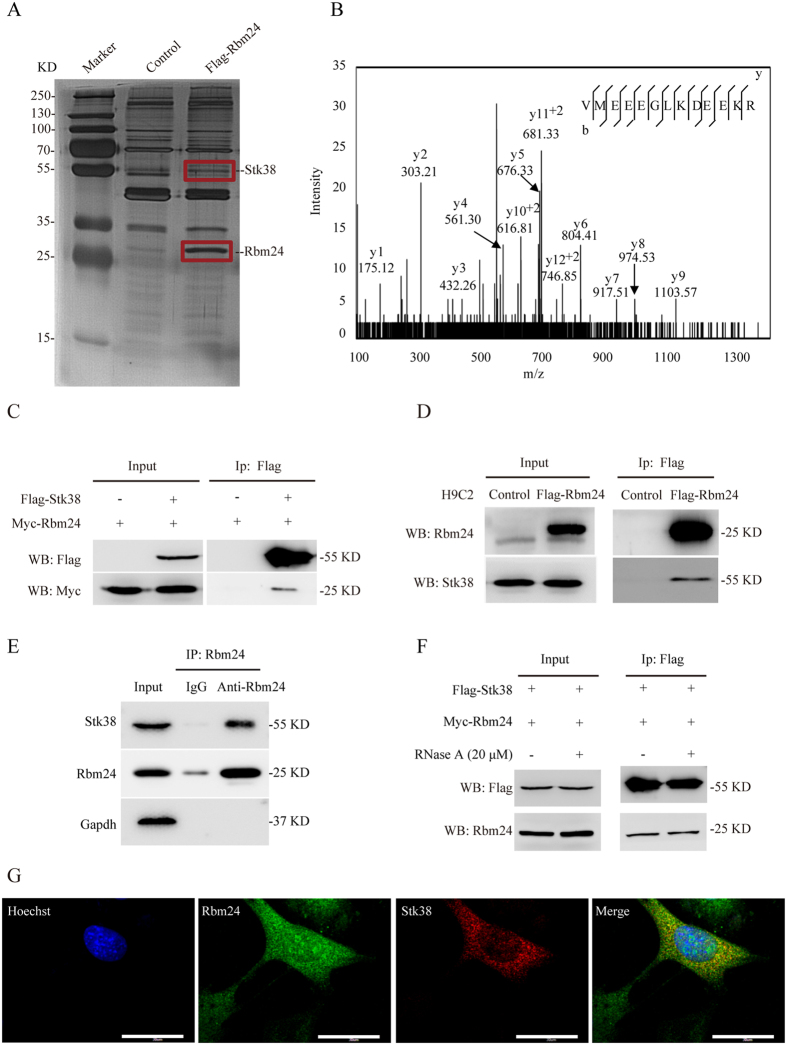
Stk38 directly interacts with Rbm24.(A) Pulldown assays with anti-Flag antibody-conjugated agarose beads were performed on lysates from H9C2-control and H9C2-Flag-Rbm24 cells. Bound proteins were eluted with Flag peptide and analyzed by silver staining. A unique protein band specific to the lysate of H9C2-Flag-Rbm24 cells was excised and identified with mass spectrometry to be the protein Stk38. The positions of Rbm24 and Stk38 on the gel were indicated to the right of the gel. (B) Representative MS/MS spectrum of a tryptic peptide (VMEEEGLKDEEKR) derived from Stk38. The assigned y ion peaks are indicated on the spectrum with respective m/z values. The b and y ions detected are indicated on the sequence. (C) Lysates from HEK293 cells transfected with Flag-Stk38 and Myc-Rbm24 were immunoprecipitated with anti-Flag antibody followed by western blot analysis. Immunoprecipitation with anti-Flag antibody showed that Rbm24 was pulled down along with Flag-Stk38, indicating their direct interaction. (D) Anti-Flag pulldown assays were performed from H9C2-control and H9C2-Flag-Rbm24 cells and analyzed by western blot using anti-Stk38 antibody. Immunoprecipitation with anti-Flag antibody showed that endogenously expressed Stk38 was pulled down along with Flag-Rbm24, further validating direct interaction between Rbm24 and Stk38.(E) Anti-Rbm24 pulldown assays were performed from HL-1 cells and analyzed by western blot using anti-Stk38 antibody. Immunoprecipitation with anti-Rbm24 antibody showed that endogenously expressed Stk38 was pulled down along with Rbm24. (F) Lysates from HEK293 cells transfected with Flag-Stk38 and Myc-Rbm24 were treated with RNase A, then immunoprecipitated with anti-Flag antibody before western blot analysis. Treatment with RNase A did not affect the interaction of Rbm24 with Stk38, indicating that their interaction is RNA-independent. (G) H9C2 was fixed and stained using anti-Stk38 (red fluorescence) and anti-Rbm24 (green fluorescence) antibody. Presence of overlapping fluorescence signal (yellow fluorescence) further indicated direct interaction of Rbm24 and Stk38 both in the cytoplasm and nucleus. Bar = 12 μm. The images of (A,C,D,E,F) shown are cropped. The full-length gel/blots or original images are shown in Fig. S1.